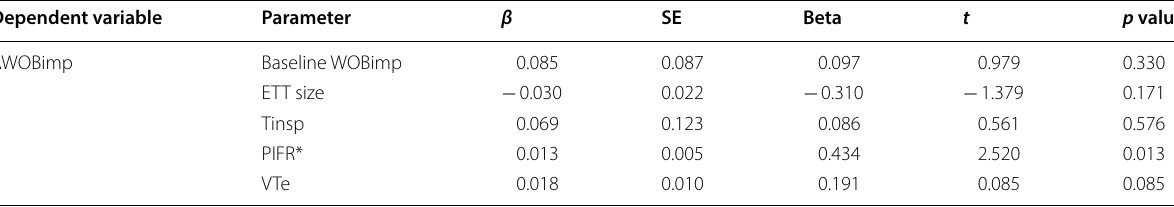
Table 3 Estimates of fixed